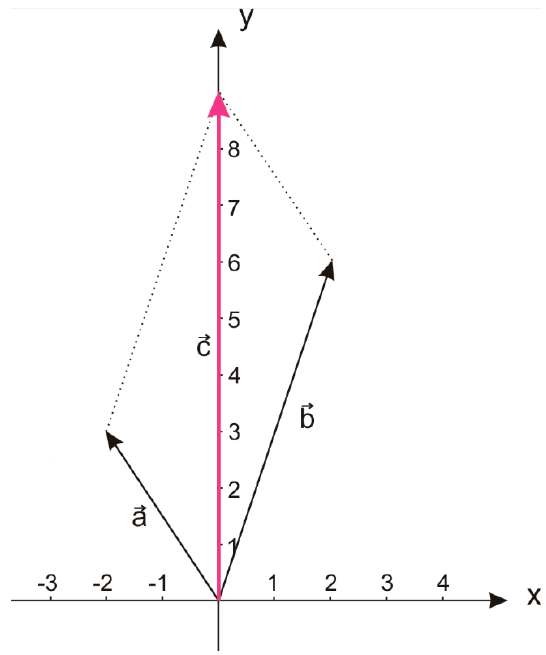
Figure 4. An example of average gradient addition: ( a , b ) average gradients; and ( c ) resultant gradient.